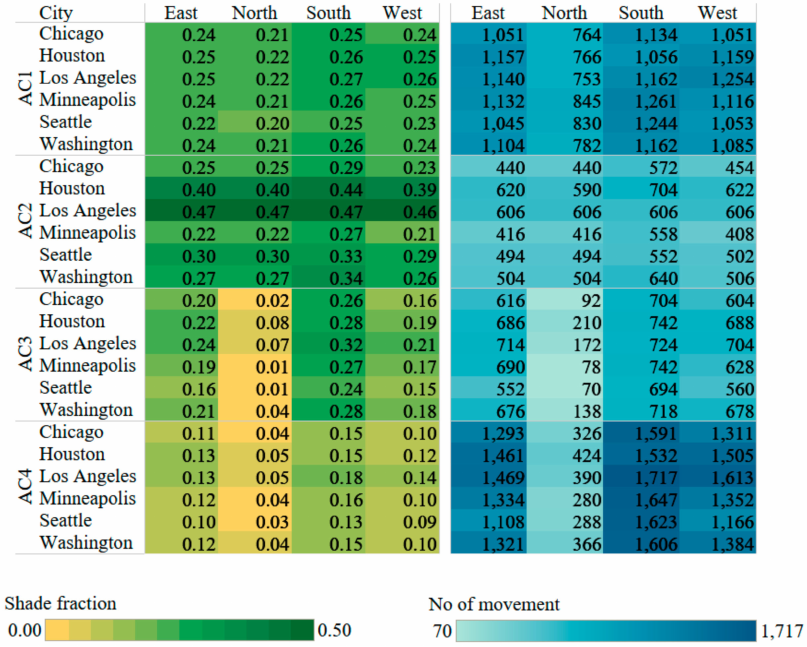
Figure 8. Fraction of window shaded by shading device and number of movements of shades for four di ff erent automated control strategies of roller shades, in di ff erent orientations at six di ff erent US